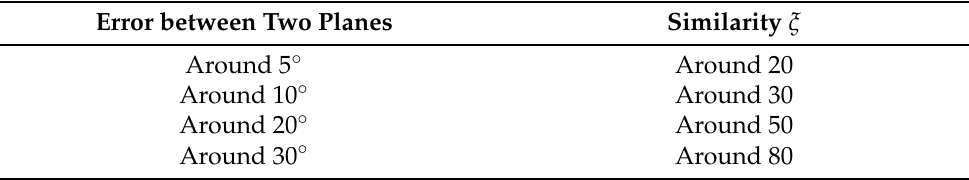
Table 4. Relations between ξ and